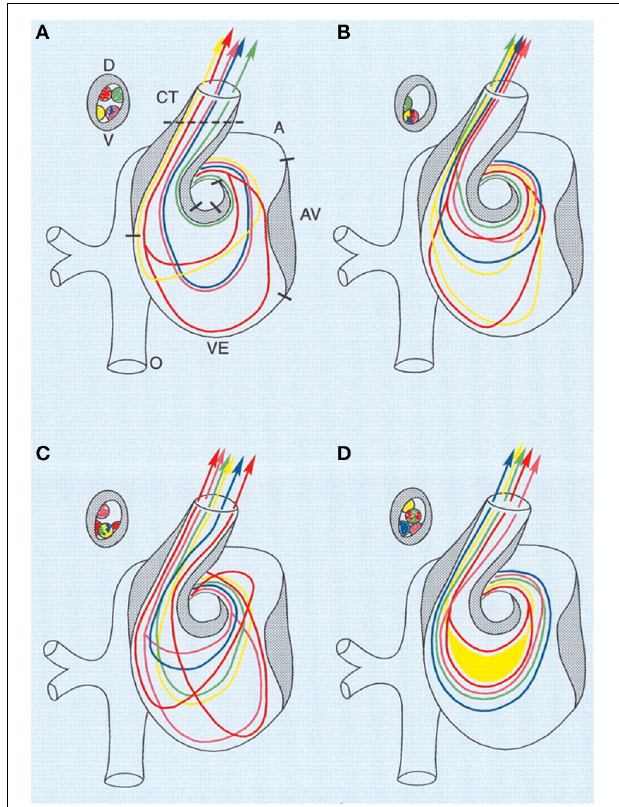
FIGURE 3 | Combined schematic representation of intracardiac flow patterns after ligation of the different vitelline veins. Each colored line represents the average flow pattern of one particular yolk sac region. (A) Normal flow pattern. (B) Flow pattern observed after ligation of the right VVL. There is a reduction of streamlines passing through the left half of the AV canal (red, yellow), and in the OFT all streamlines were located along the lateral-most half and also more ventrally. (C) Flow pattern observed after ligation of the left VVL. By crossing from the inner curvature to the outer curvature, the pink streamline is added to the left half of the AV canal. Both red streamlines are sharply edged in the left atrium, ventricular inflow and outflow. (D) Flow pattern observed after posterior VVL. Most streamlines were running centrally through the AV canal, with hardly any flow along the outer curvature of the ventricle and the inner curvature of the OFT. Green, anterior yolk sac region; pink, right lateral yolk sac; blue, left lateral yolk sac; yellow, posterior yolk sac, single streamline; red, posterior yolk sac, double streamline. A, atrium; AV, atrioventricular canal; CT, conotruncus, or heart outflow tract; D, dorsal; V, ventral; VE, ventricle. Image reproduced with permission from Hogers et al.